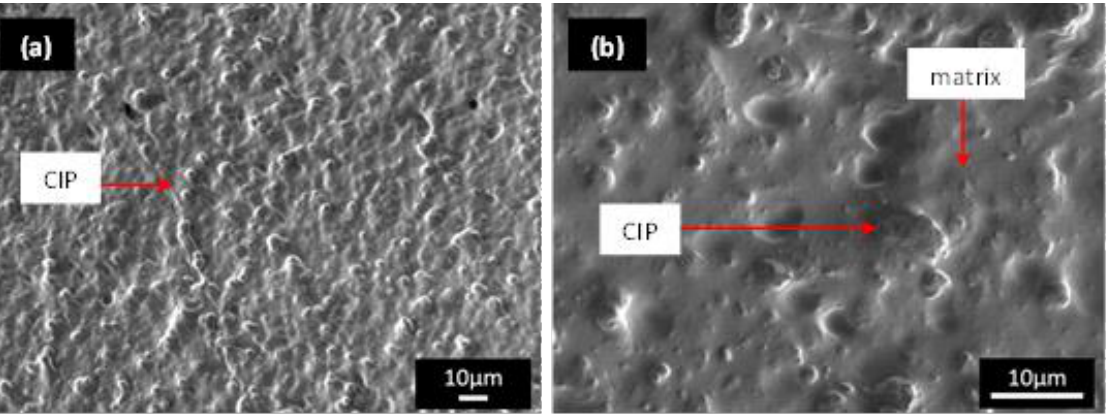
Figure 1. FESEM images of particle dispersion in an isotropic distribution of MRE at ( a ) low (×600) and ( b ) high (×2000) magnifications before the durability shear test.